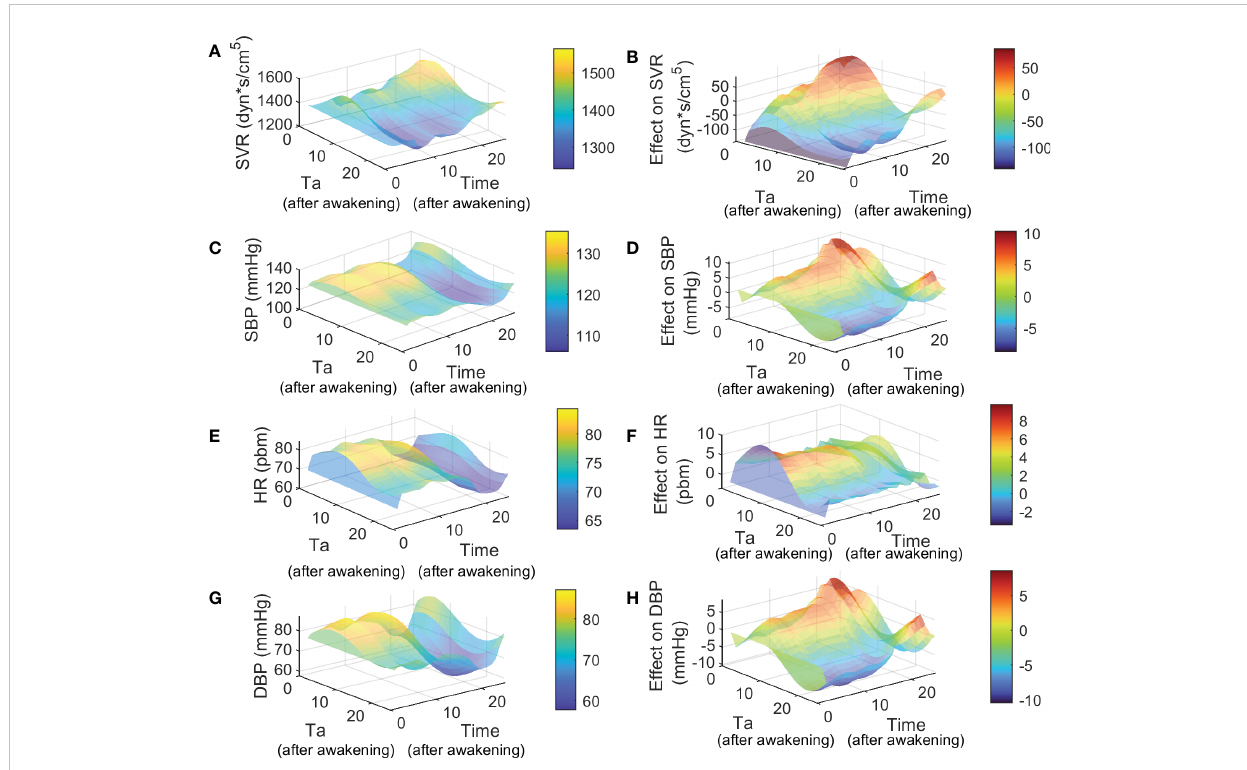
FIGURE 7 Simulation and effect results of Ta-dependent effect model of aspirin using p before of awakening group. Figures (A, C, E, G) show the 24 hours simulation results (hours after awakening) of SVR, SBP, HR and DBP for different Ta from 0 to 24 hours (hours after awakening), respectively. Figures (B, D, F, H) show the 24 hours effect results (hours after awakening) of SVR, SBP, HR and DBP for different Ta from 0 to 24 hours (hours after awakening),